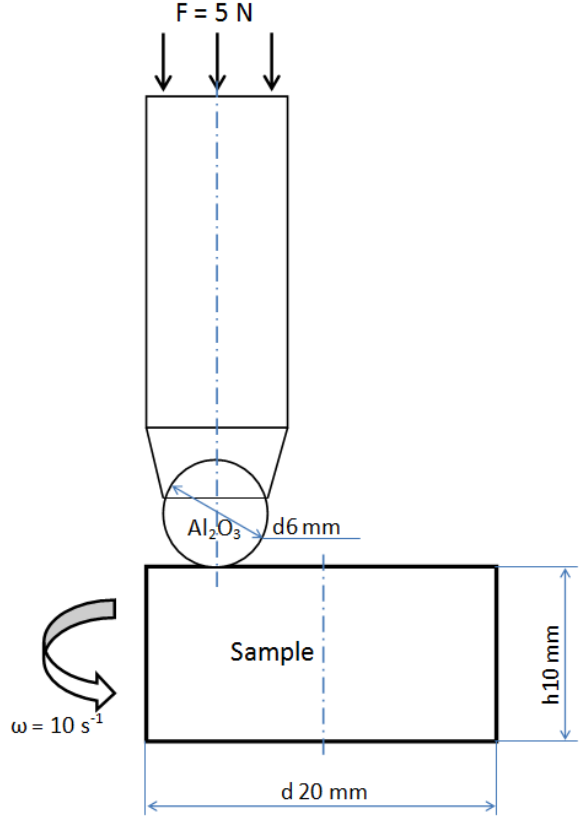
Figure 2. Scheme of testing samples for dry friction abrasion.